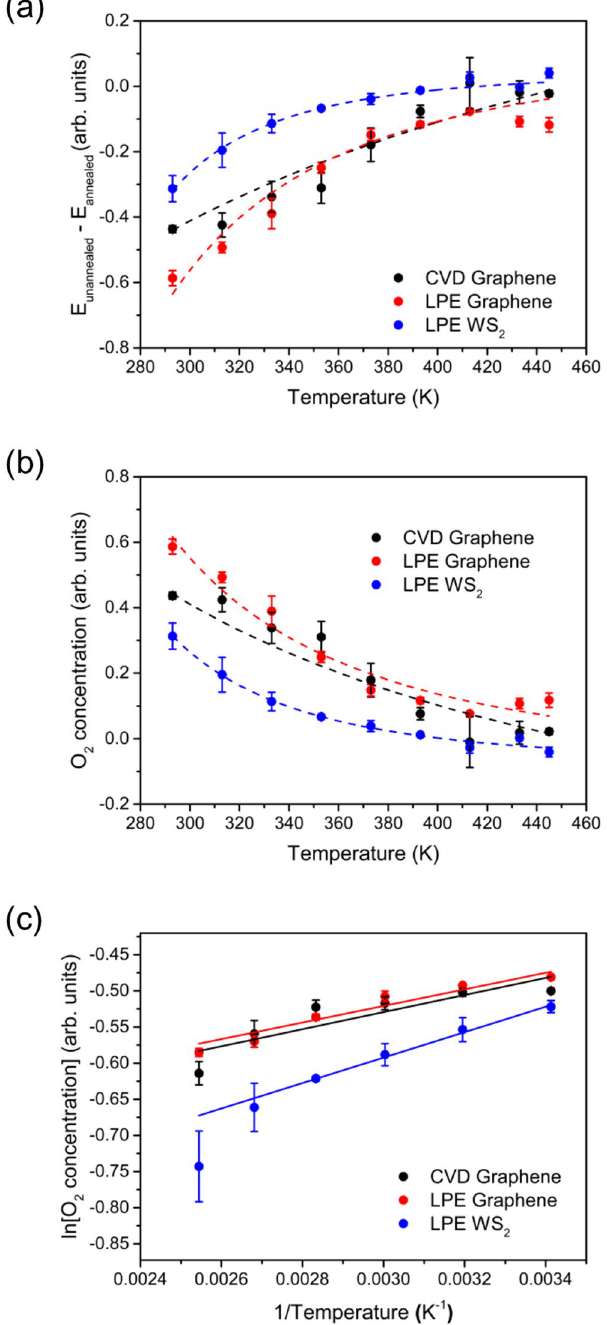
Figure 4. Determination of the desorption energy. ( a ) Peak versus temperature of waveforms ( − ≅ E E E ) for all samples. ( b ) Concentration ( N ad ) of O 2 adsorbates on surface of samples unannealed annealed O 2 as a function of temperature. ( c ) In ( N ad ) versus T 1/ with linear fit for calculating desorption